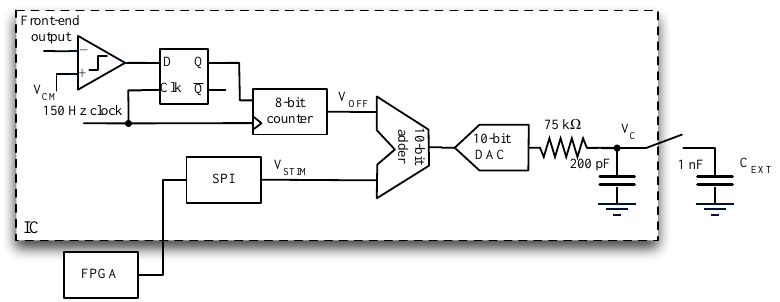
Figure 8. Architecture of the offset compensation loop. The offset compensation voltage V OFF is generated comparing the output of the frontend v OUT with V CM and then incrementing a 8-bit counter. Stimulus signal v STIM comes from the FPGA and is summed to V OFF and fed to a DAC so as to create voltage v C A passive LPF filter at DAC output limits the noise.